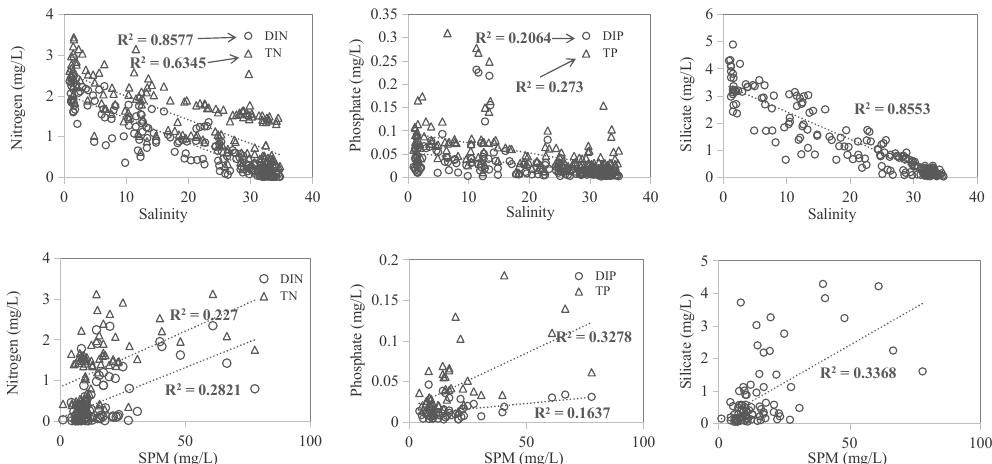
Figure 6. Plot showing the correlations between nutrient concentrations (N, P, and Si) and hydrological parameters (salinity and suspended particulate matter) in the Pearl River estuary.